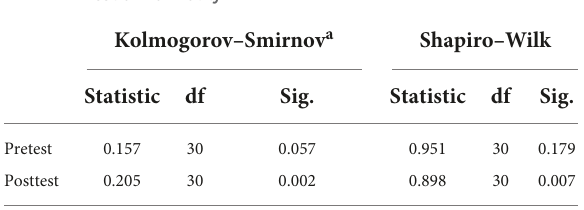
TABLE 4 Test of